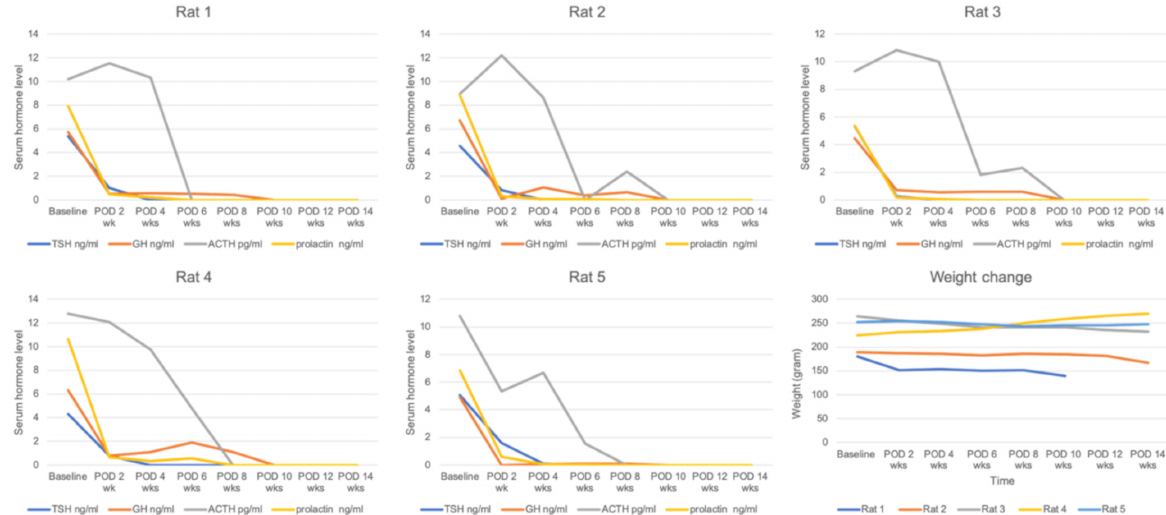
Figure 4. Serum hormone changes of five rats with adequate removal of the pituitary gland over time. The serum TSH level gradually decreased. It was not detected at 4–6 weeks postoperation. Serum GH and prolactin levels abruptly decreased at two weeks postoperation and were maintained until 6–8 weeks. Serum ACTH levels were maintained until 4–6 weeks and sharply dropped 6–8 weeks postoperation. The body weights of correctly hypophysectomized rats seldom changed until 14 weeks. POD, postoperative